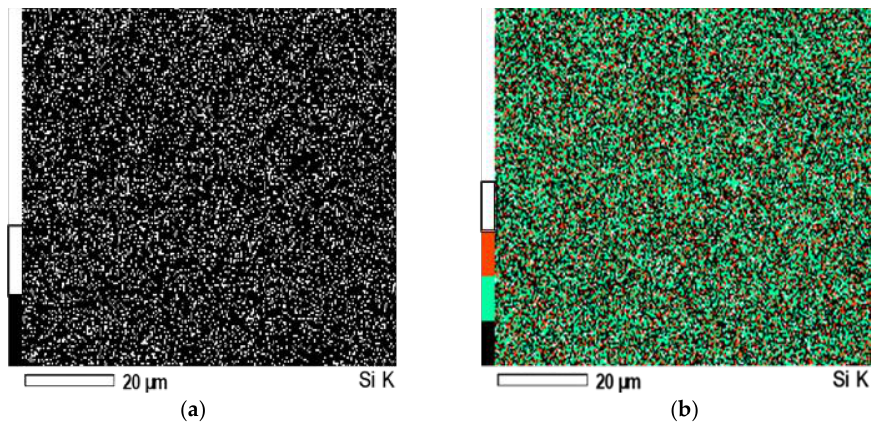
Figure 1. SEM-EDX images taken on fracture surfaces of samples No. 5 and No. 6. ( a ) Sample No. 5. ( b ) Sample No. 6.